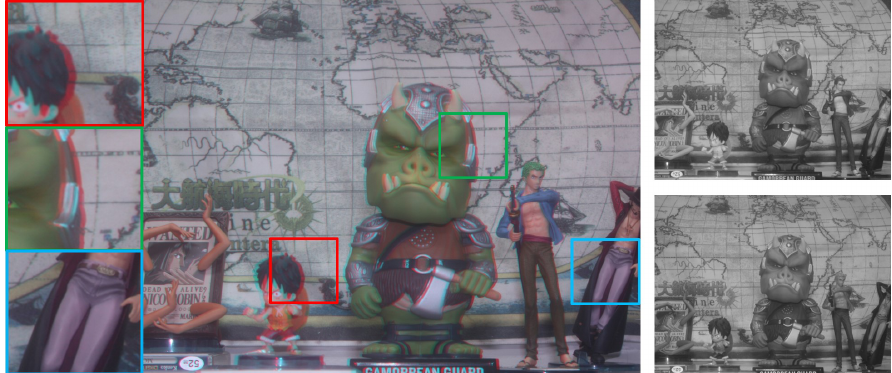
Figure 3. Left : Acquired image using the DCA camera; upper right : the red channel image; and lower right : the green channel image.